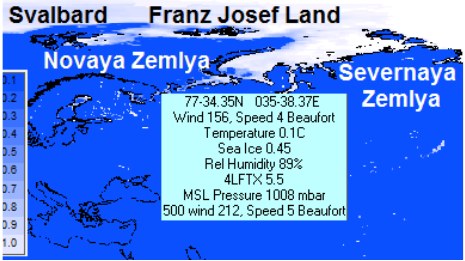
Fig. 7. General map of the Arctic Ocean in a geogra- phical system No. 10 in GRIB-2 format issued by